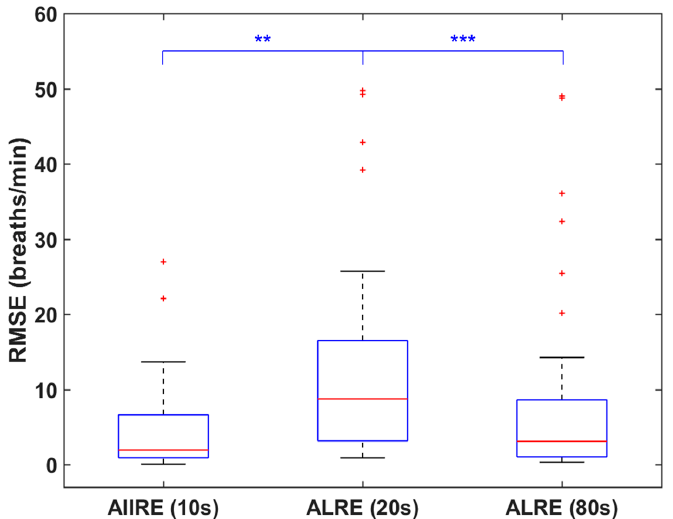
Figure 3. Distributions of root mean square errors (RMSEs) of respiratory rate (RR) estimation results when the proposed method and the adaptive lattice-type respiratory rate estimator (ALRE) were applied to the same dataset. Lower quartile, median, and upper quartile values are displayed in the box plots. Whiskers are used to represent the most extreme values within 1.5 times the interquartile range from the quartile. Outliers are displayed as crosses. ** ( p < 0.01) and *** ( p < 0.001) represent a